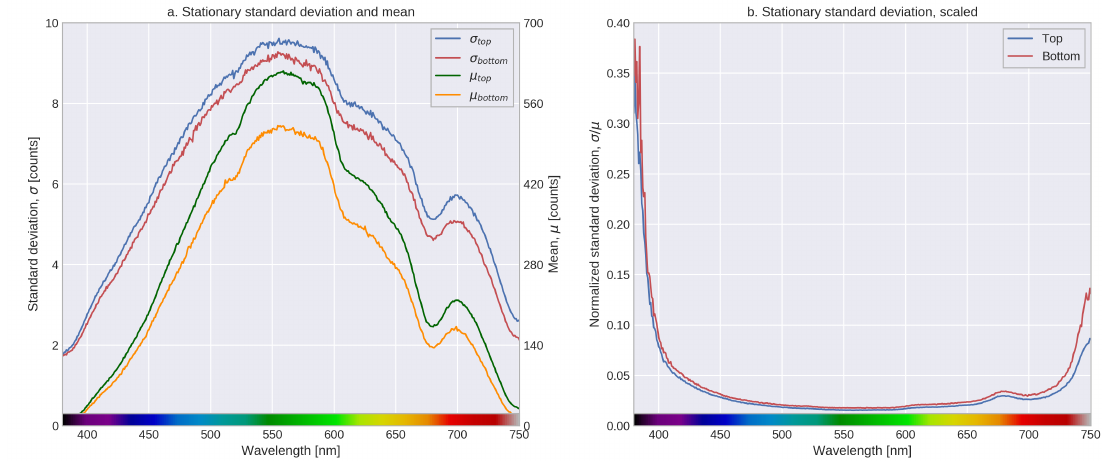
Figure 4. ( a ) Standard deviation and mean as a function of wavelength at the top and bottom of the calibration plate. The standard deviations were for the most part in the range of 2–4% of the measured digital counts. The mean measurements were taken across the centre line. The ambient noise level (i.e., with lights turned off) was σ amb = 1.6 digital counts across all wavelengths. ( b ) The same standard deviations at the bottom and top of the plate, normalised by the respective